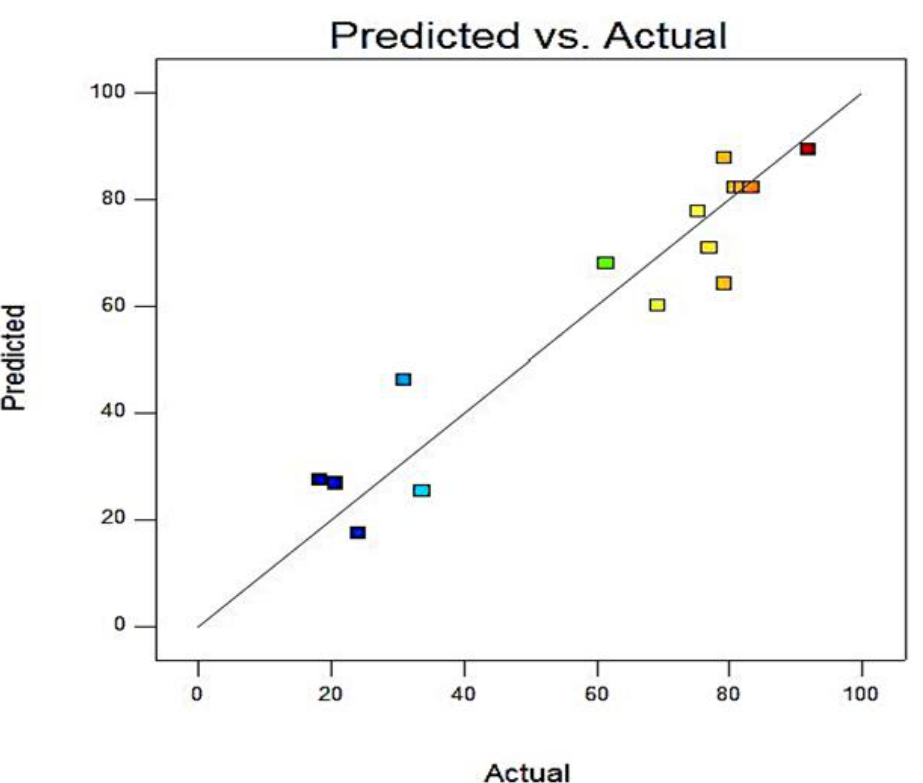
Figure 2. Comparison of theoretical and measured yield percent values.